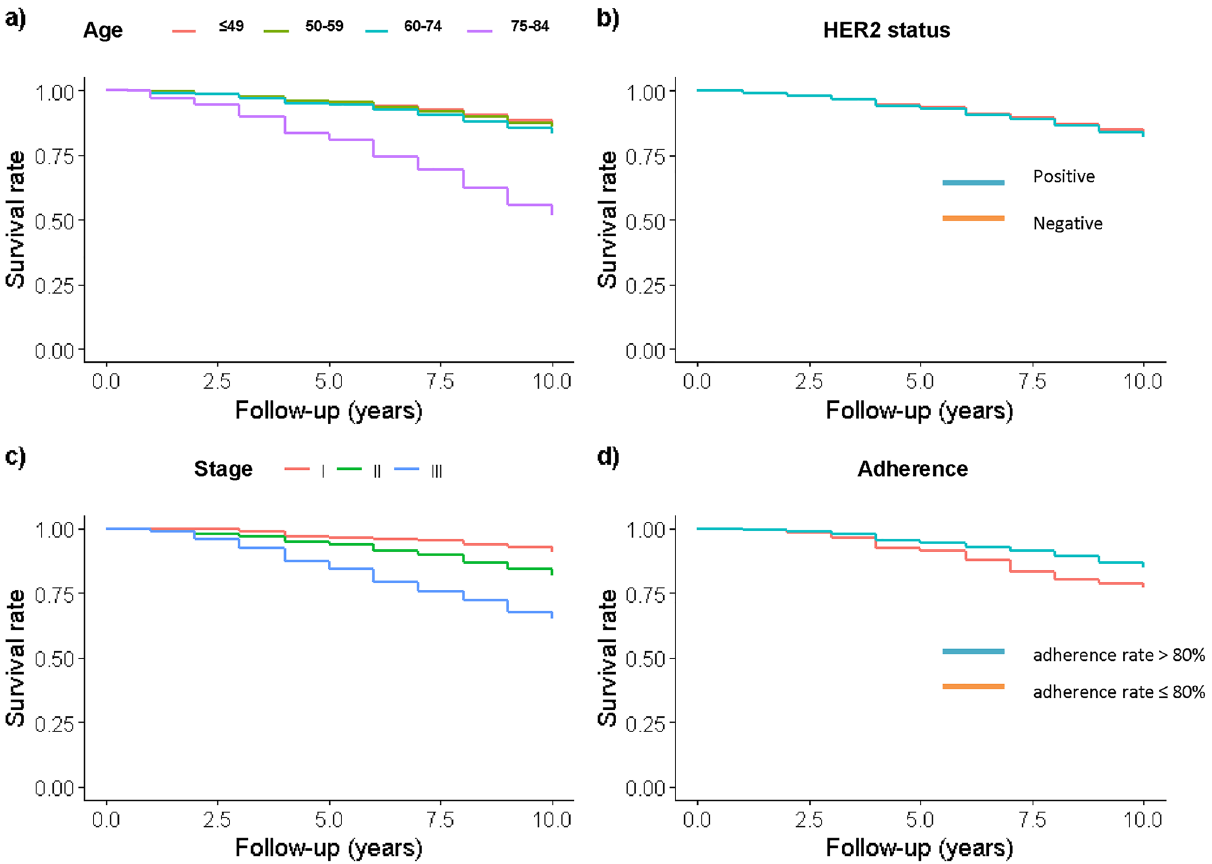
Figure 1. Patients diagnosed with hormone receptor-positive breast cancer before the age of 85 years in Girona and Tarragona: age-adjusted survival curves according to ( a ) age groups, ( b ) HER2 status, ( c ) stage at diagnosis, and ( d ) adherence to endocrine